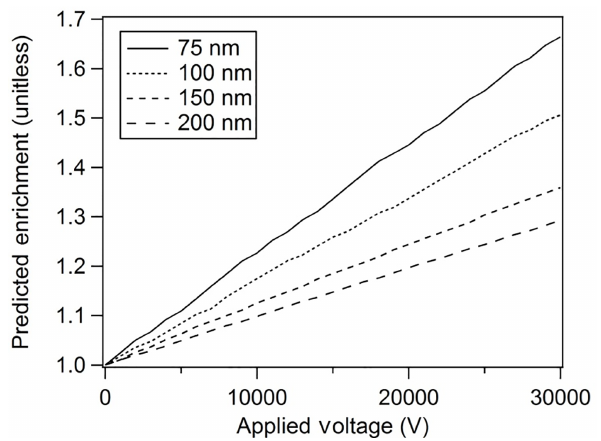
Figure 3. Predicted enrichment versus applied voltage under exper- imental operating conditions. Table 2. Prototype concentrator